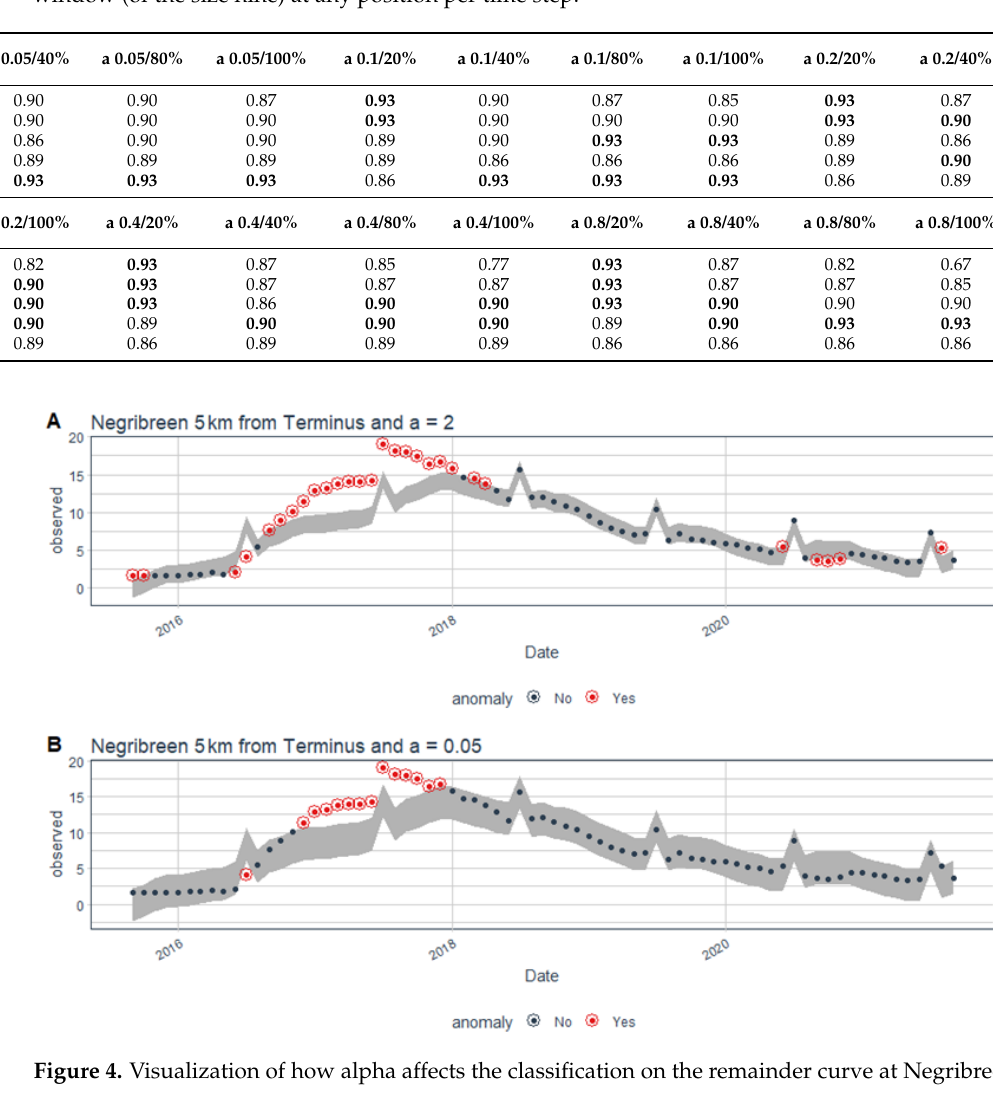
Table 3. Correlation matrix of Strongbreen with velocity extraction every 500 m with a 250 m buffer compared to Benn et al. [44]. The cluster threshold marks the amount of anomalies within the moving window (of the size nine) at any position per time step.